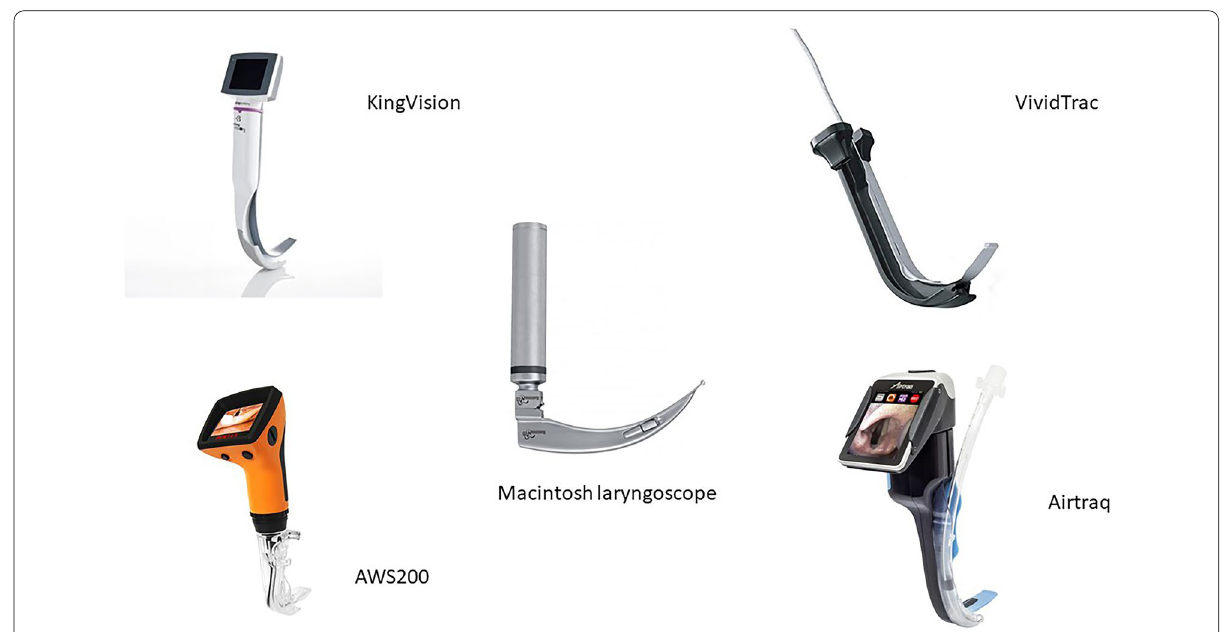
Fig. 1 Videolaryngoscopes used in the MACMAN2